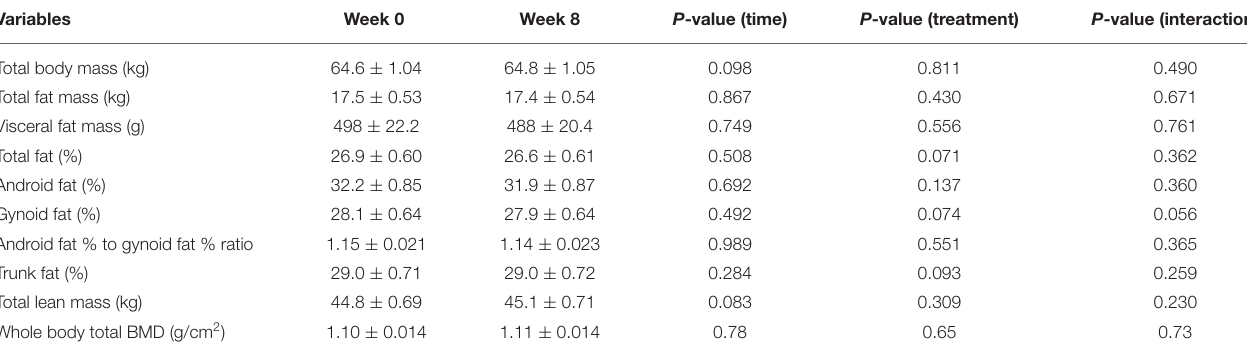
TABLE 5 | Baseline and end of intervention (week 8) body composition measurements obtained using DXA in men.